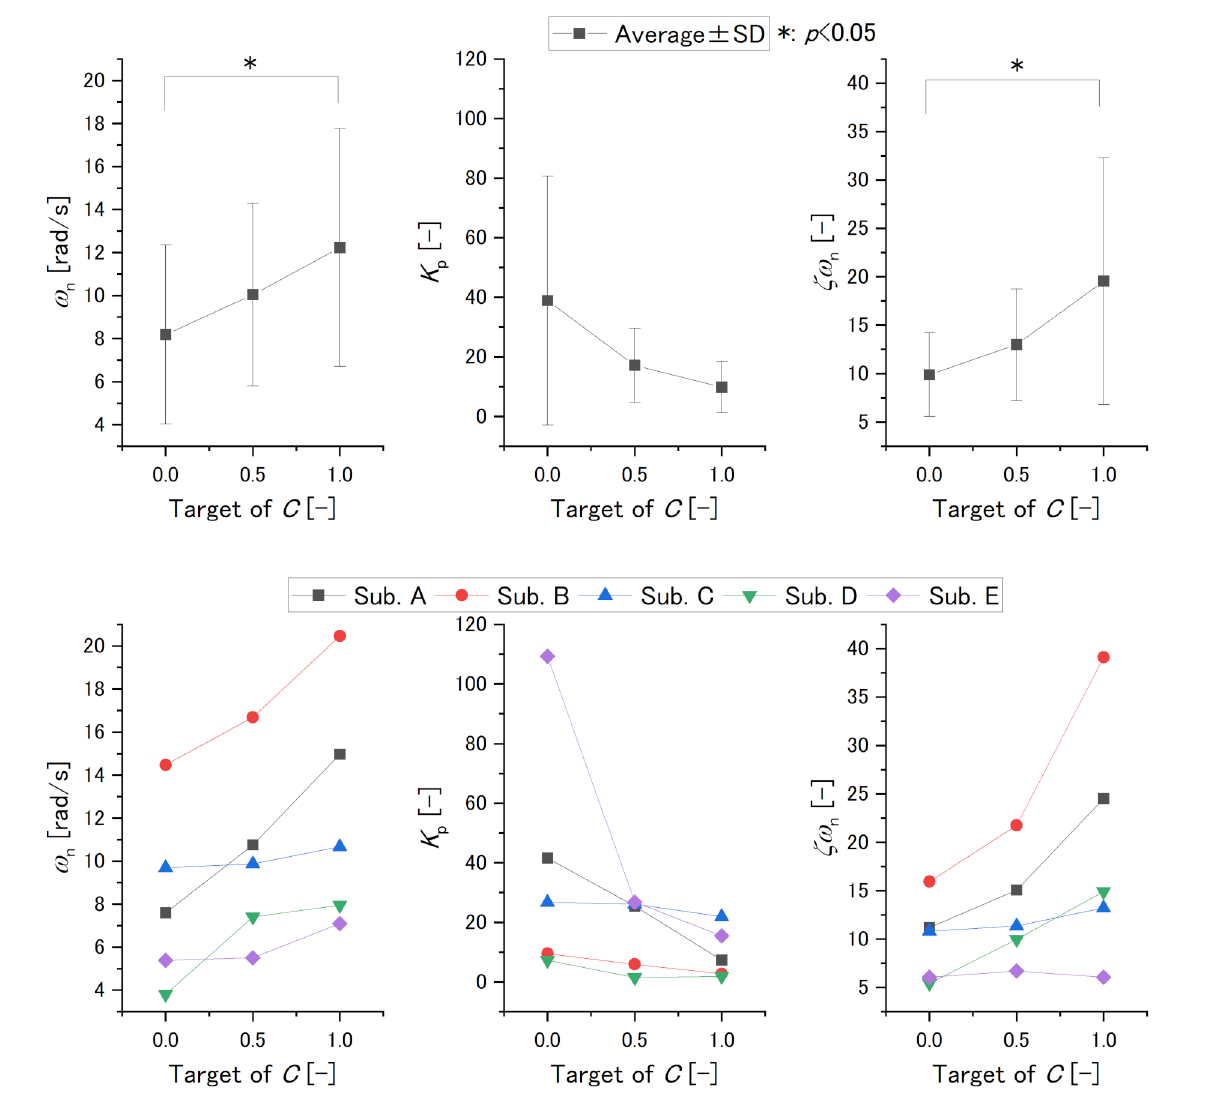
Figure 9. The results of ω n ( left ), K p ( center ), ζω n ( right ). Upper figures are averages and SDs. Lower figures are individual values. Table 3. Statistics